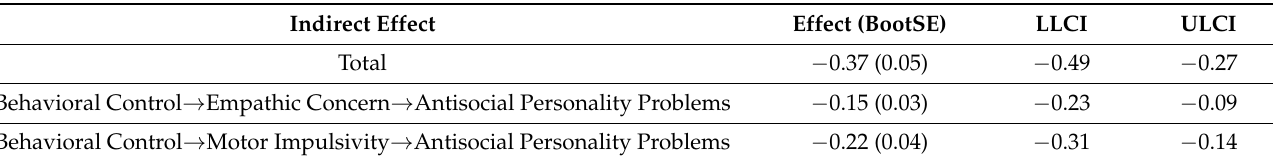
Table 4. Indirect effects of behavioral control on antisocial personality problems through motor impulsivity and empathic